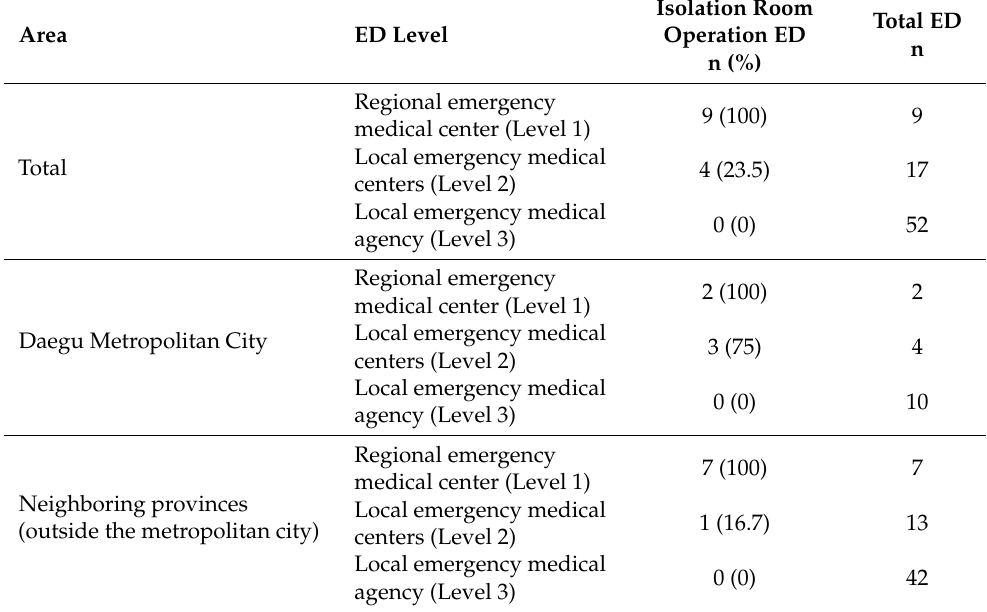
Table 1. Operational status of isolation rooms by ED level and area.